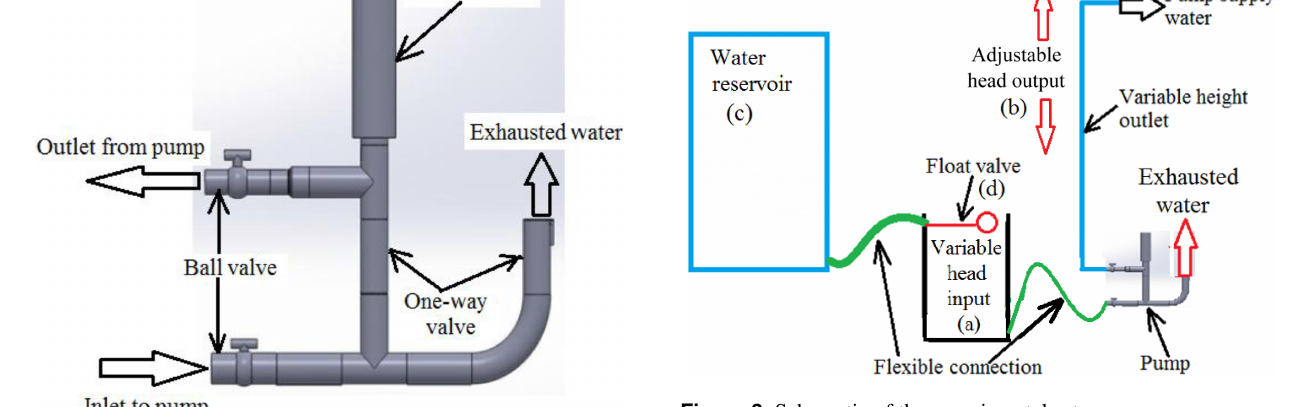
Figure 3. Schematic of the experimental